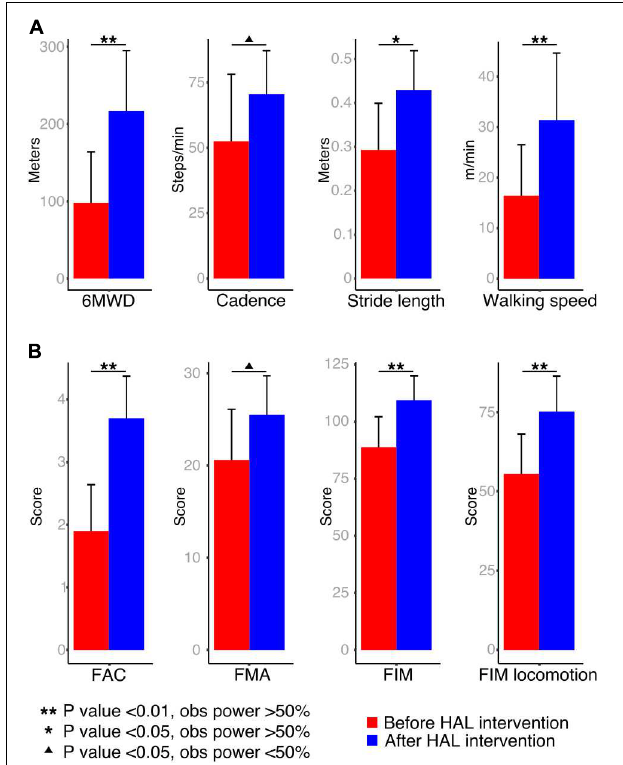
FIGURE 1 | Walking performance and clinical scores: (A) patients were assessed during a 6-min walking distance test and cadence, stride length and walking speed were calculated from recordings. (B) To evaluate the degree of functionality of patients, the Functional Ambulation Classification (FAC), Fugl-Meyer Assessment (FMA), Functional Independence Measure (FIM) total, and locomotion scores were